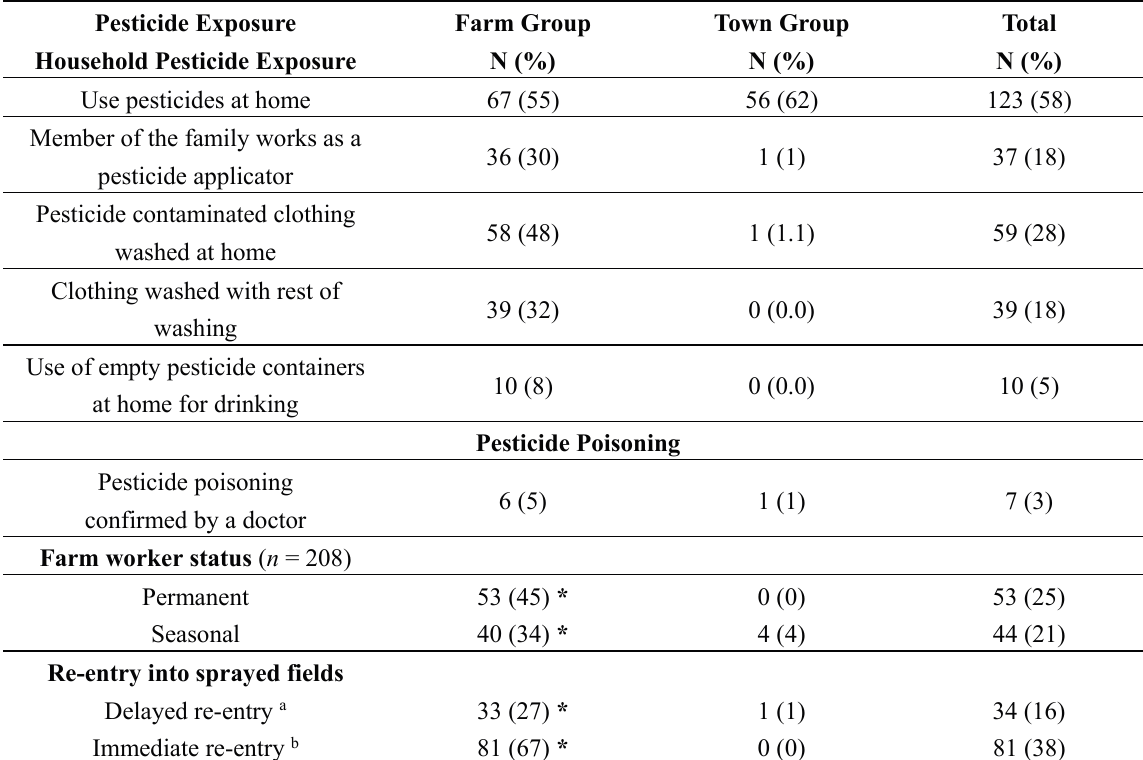
Table 2. Household pesticide exposure, pesticide poisoning and agricultural pesticide exposure of